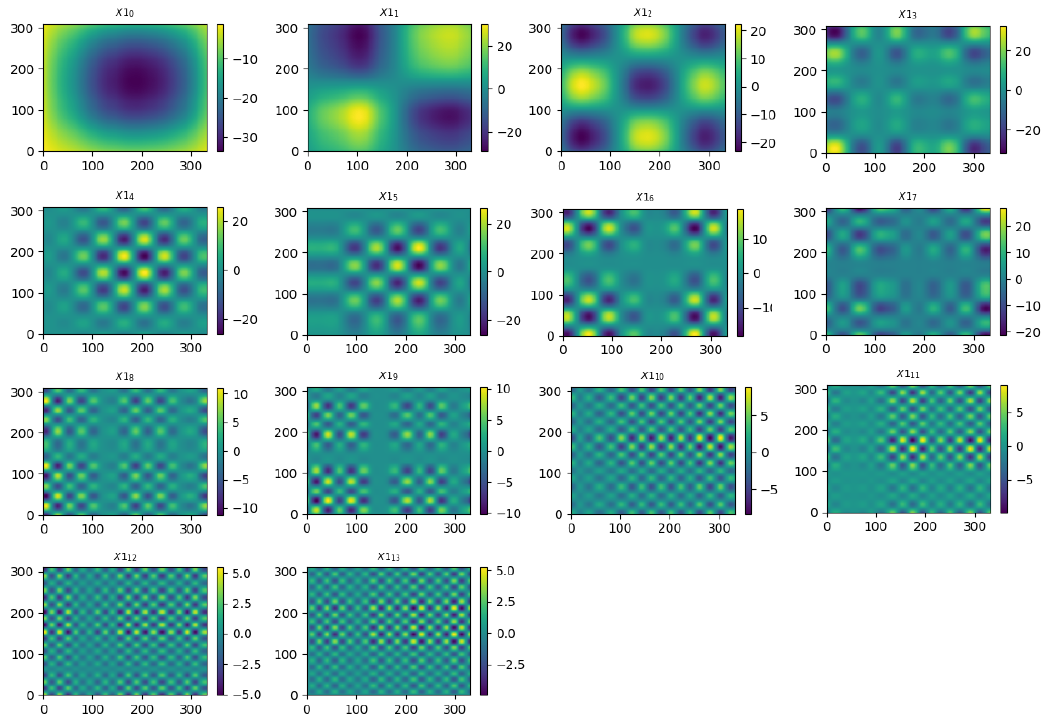
Figure 3. The first 14 matrices obtained as a result of singular spectrum decomposition of the trajectory matrix X1. Table 2. The relative contribution of the first 20 decomposition matrices X1 i .